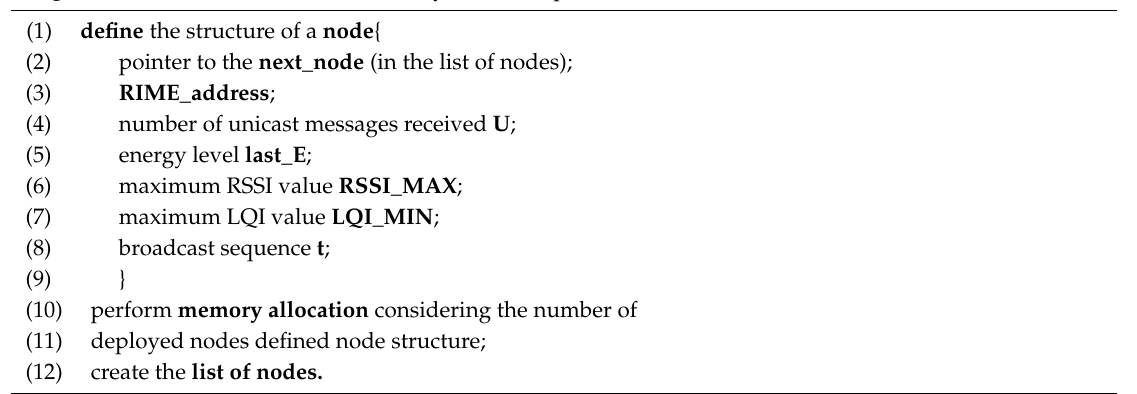
Algorithm 1 . Node structure and memory allocation